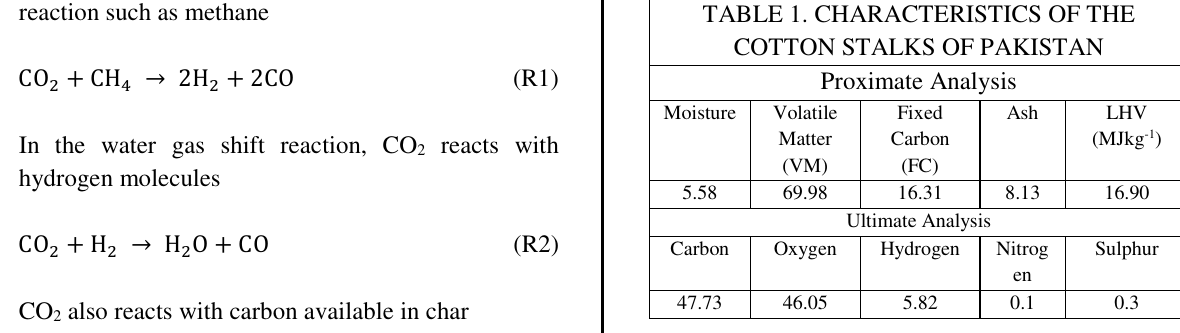
TABLE 1. CHARACTERISTICS OF